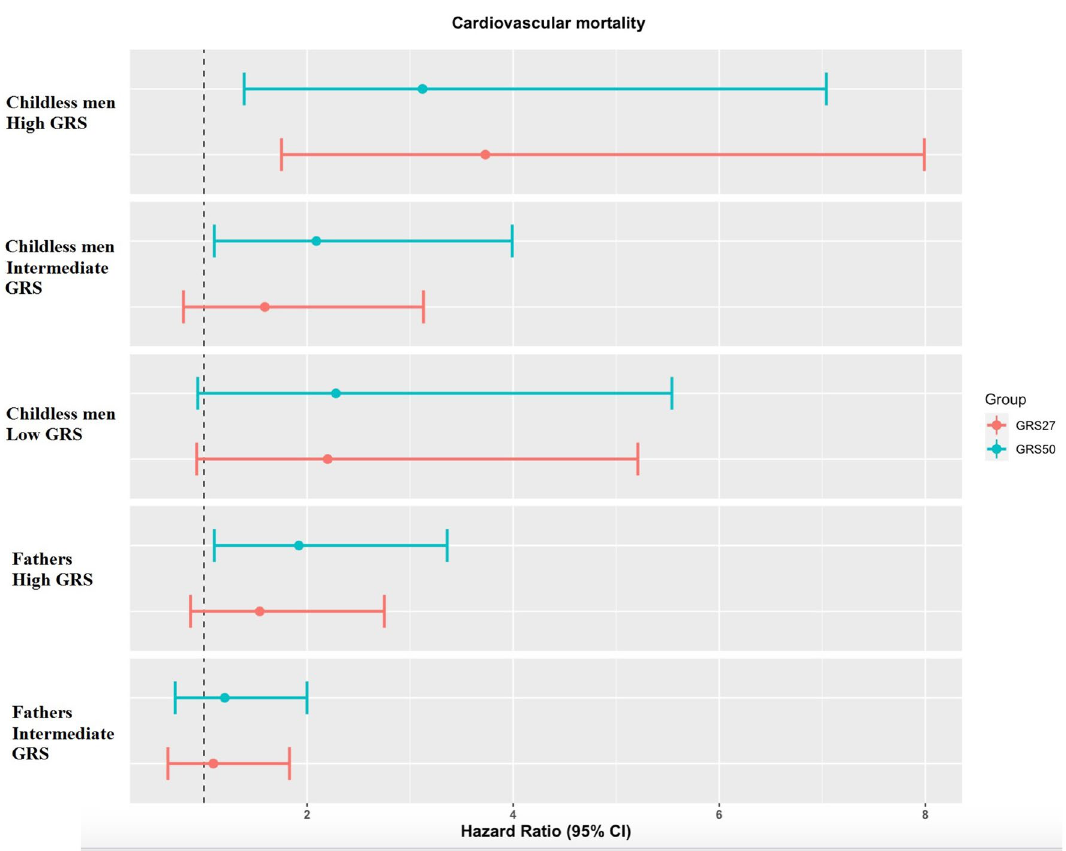
Figure 2. Competing risk regression for cardiovascular mortality among study groups using age as underlying timescale. Death unrelated to CVD is regarded as competing risk. The model is adjusted for BMI, smoking, alcohol consumption, marital status, family history of CVD, educational level, diabetes, cholesterol, triglycerides. Data source—MDC-CVC